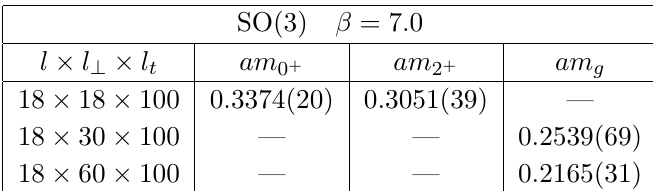
Figure 4 . Lightest scalar ( (cid:15) ) and tensor ( (cid:4) ) glueballs in SO(3) on various spatial volumes, l 2 , all in units of the in(cid:12)nite volume mass gap M g . And same for SU(2) ( (cid:14) ; (cid:3) respectively). Also shown is twice the fundamental (cid:13)ux loop mass in SU(2) ( 4 ).